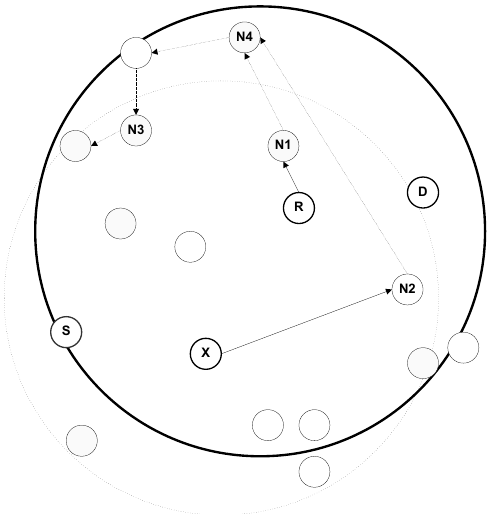
Figure 8. Opportunistic relay selection scenario (from work in